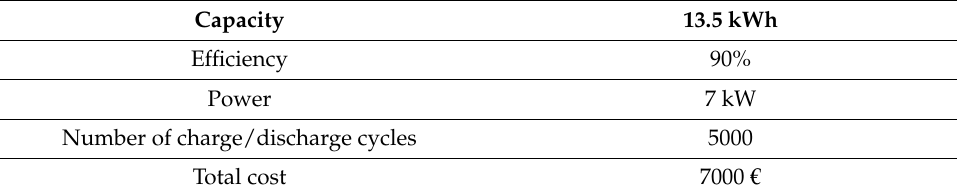
Table 3. Battery Storage Characteristics [31].